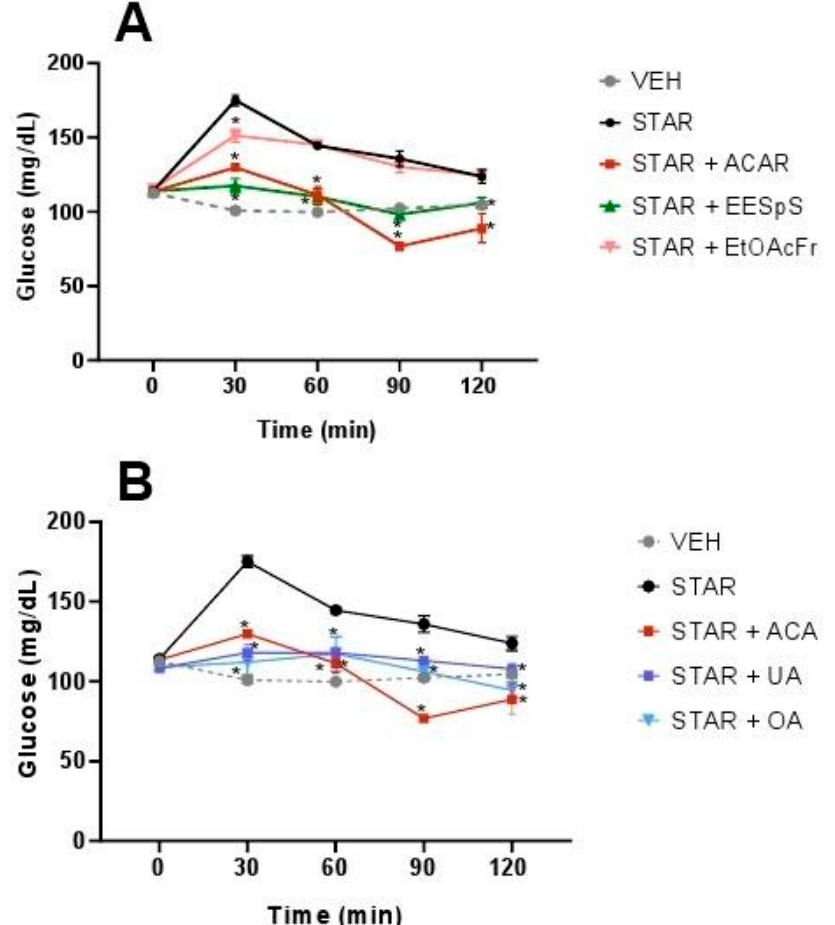
Figure 3. Effect of products obtained from the stems from S. polystachya in oral starch tolerance test (OStTT). ( A ) OStTT of groups treated with starch, acarbose, EESpS and EtOAcFr, as well as vehicle. ( B ) OStTT of groups treated with starch, acarbose, UA and OA, as well as vehicle. Results shown as mean ± SEM ( n = 6). * p > 0.05 significantly different vs. starch group values at the same time. (Two-way ANOVA followed by Dunnett post hoc test) ACAR: acarbose; STAR: starch; EESpS: ethanolic extract of stem; EtOAcFr: ethyl acetate fraction; UA: ursolic acid and OA: oleanolic acid. 2.1.4. Oral Glucose and Galactose Tolerance Tests of the Products Obtained from Stems from S.